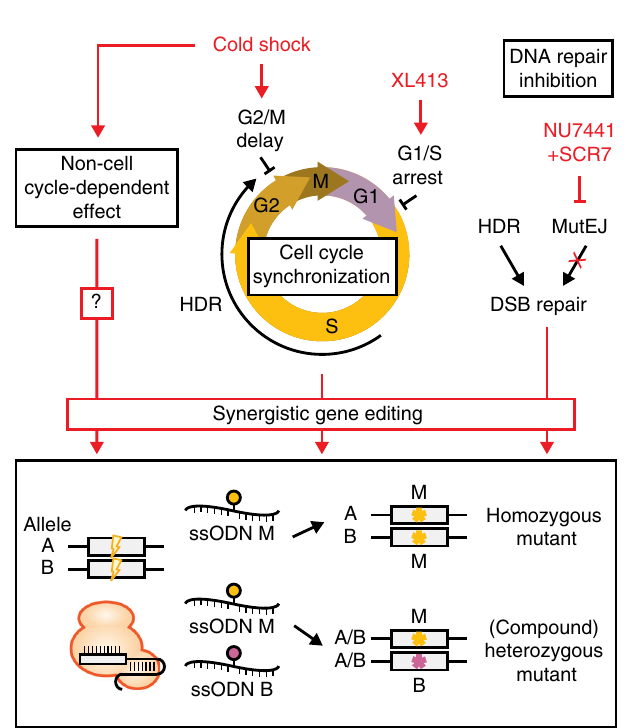
Fig. 7 Summary of synergistic gene editing effects favoring HDR outcomes. Synchronization and release of cells into the HDR permissive S and G2 phases of the cell-cycle synergizes with DNA repair inhibition to improve HDR rates. Additional non-cell-cycle-dependent effects of cold shock may also play a role. Leveraging these mechanisms, homozygous mutations are generated at high ef fi ciency, while heterozygous mutations may be generated without indels by using a combination of mutant and blocking ssODN Regulation of the cell cycle is an ongoing area of interest in the fi elds of DNA repair and gene editing. It has been proposed that increased CDK activity in S phase stimulates phosphorylation of key HDR proteins such as CtIP, promoting DSB end resection and HDR 61 . Cell-cycle synchronization at the G1/S boundary with Aphidicolin and in late G2/M phase with Nocodazole was shown to enhance HDR frequency 34,35 . Furthermore, simulta- neous promotion of G1/S transition by Cyclin D1 (CCND1) overexpression and cell-cycle synchronization in G2/M phase with nocodazole was reported to further improve HDR ef fi -